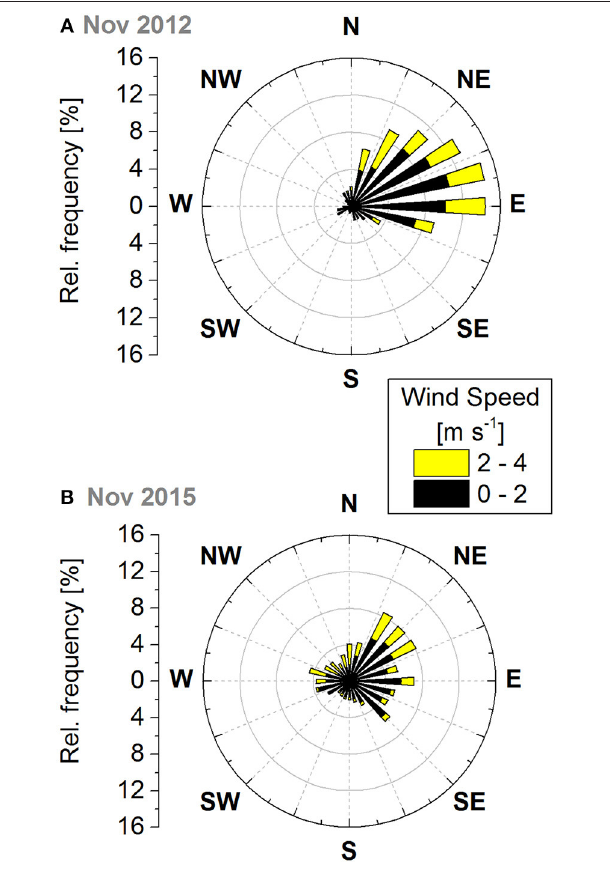
FIGURE 2 | Frequency distribution of wind directions and wind speed in m s − 1 measured (A) at 36m above ground level from November 01 to 28, 2012 and (B) at 41m above ground level from November 11 to 23,